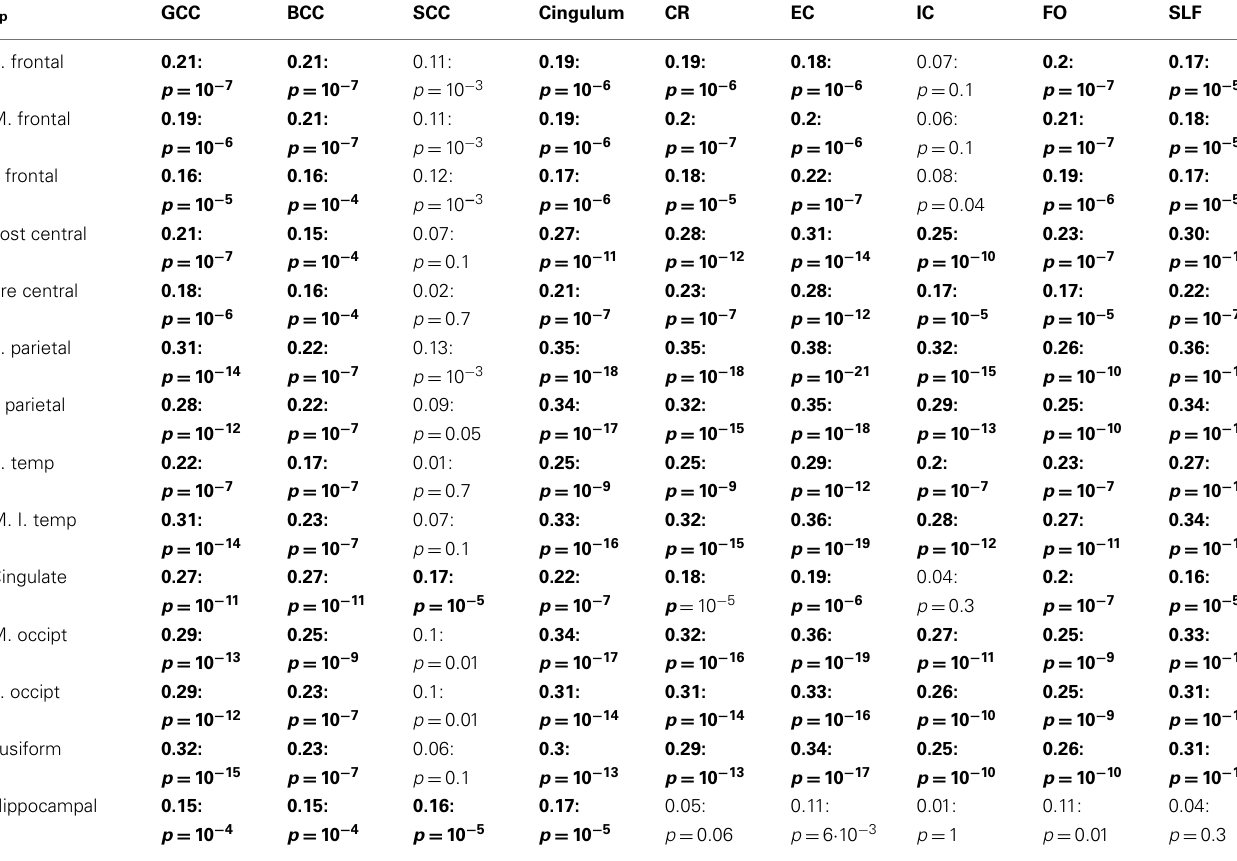
Table 2 | Phenotypic, corrected for age and sex, correlation coefficients between regional GM thickness values, and by tract FA measurements. r p GCC BCC SCC Cingulum CR EC IC